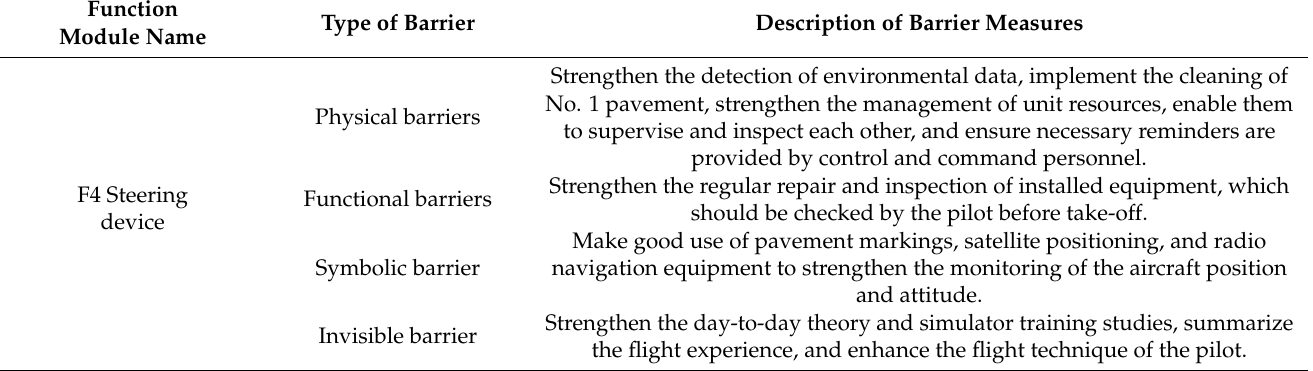
Table 14. “F4: Steering device” safety barrier.